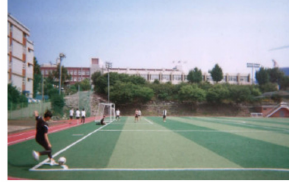
Figure 8. Soccer field.